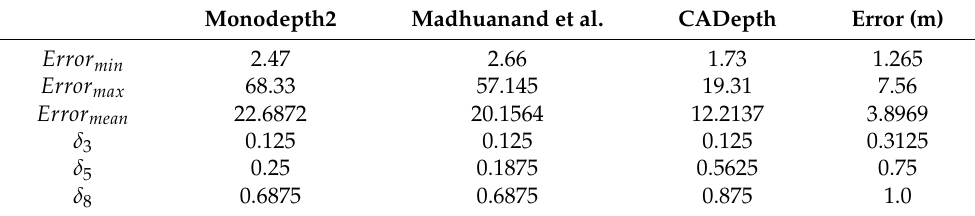
Table 4. Target positioning result with different depth estimate